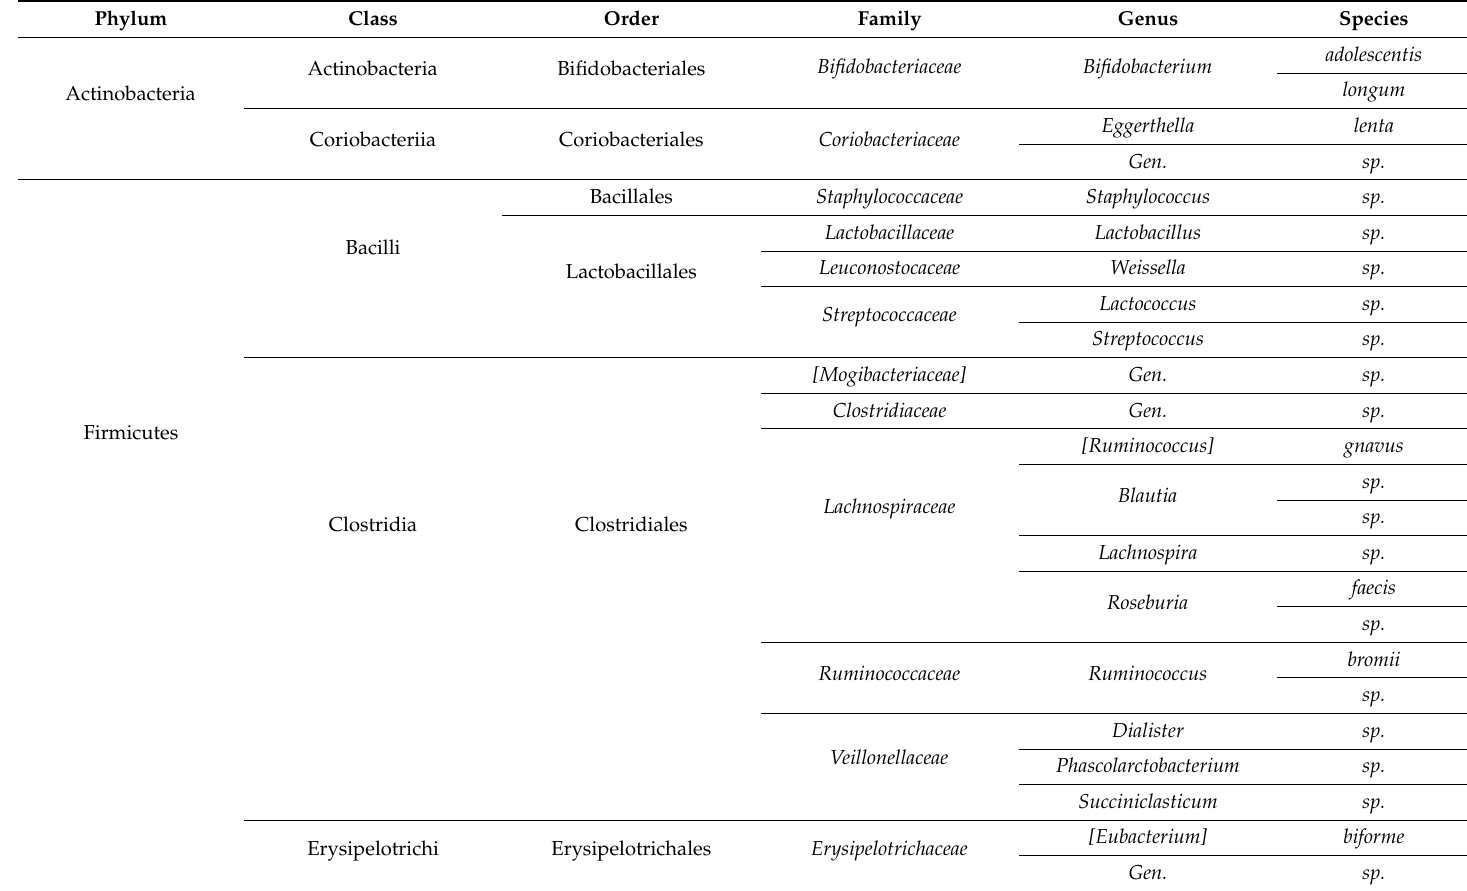
Table A1. 27 least abundant species. Obtained by identifying the five species with the lowest relative abundance for Control 0 and 24 and per each of the six stilbenoids. Gen. = unnamed genus, sp. = unnamed